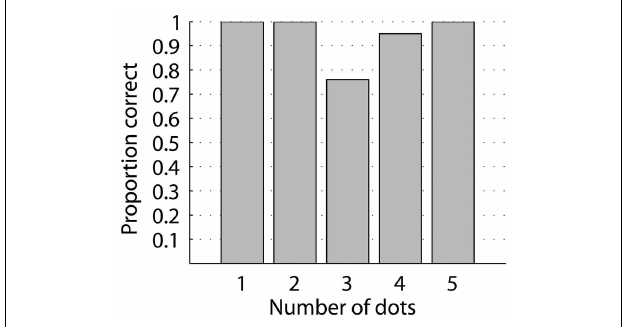
FIGURE 4 | Identification of single letters as a function of letter complexity, measured as the number of dots forming a letter. All letter complexities have high identification rate and there is no systematic change in identification with complexity.